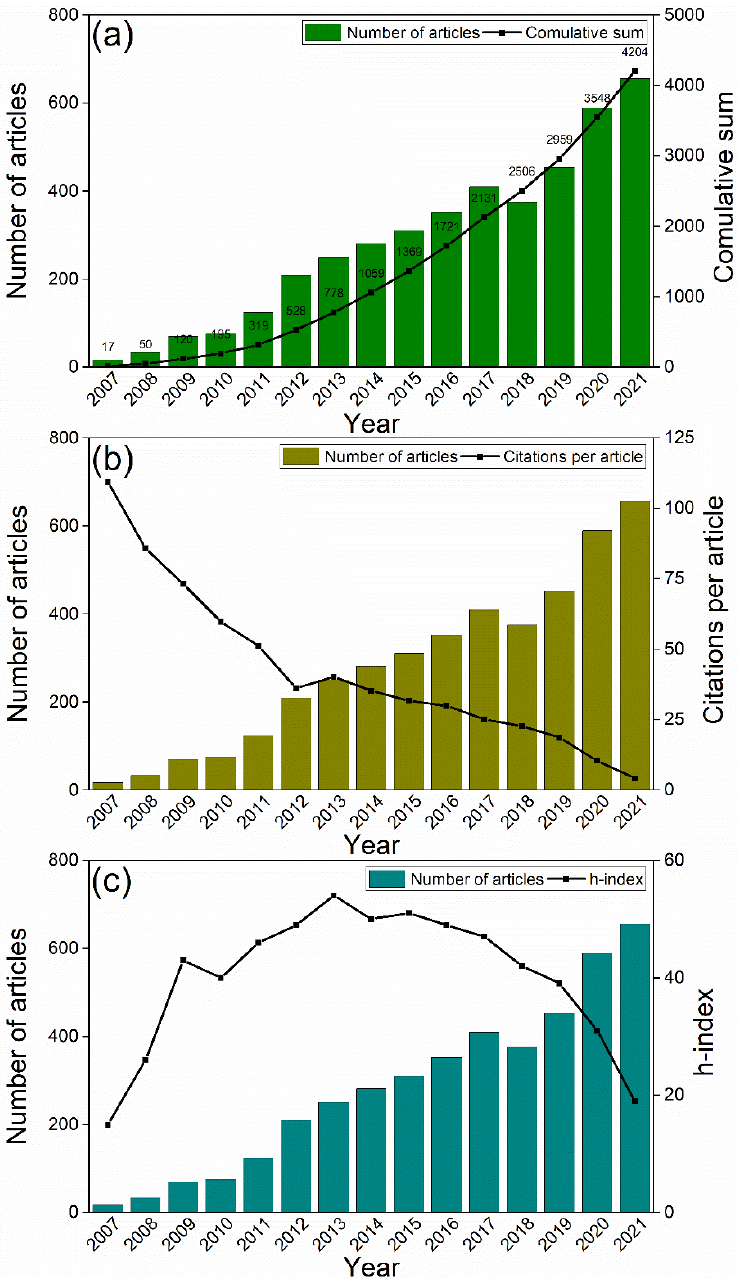
Figure 3. Publication growth over the year, ( a ) total publications and cumulative sum, ( b ) total publications and citations by year, ( c ) total publications and h-index.